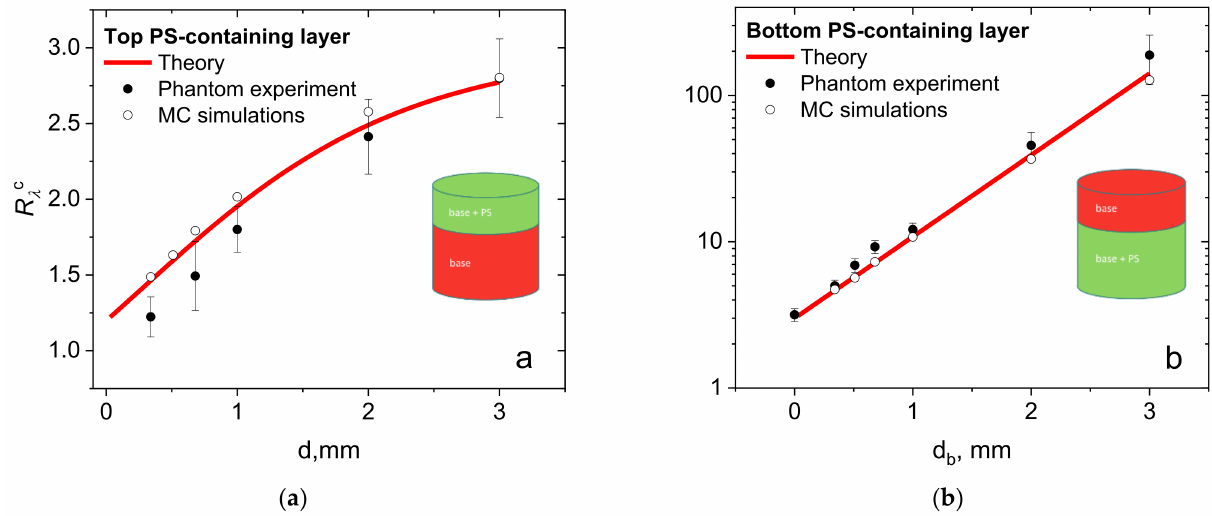
Figure 5. Experimentally measured fluorescence signal ratio for the agarose biotissue phantoms with ( a ) a PS-containing top layer and ( b ) a PS-containing bottom layer versus the PS localization depth, corresponding analytical dependencies and results of the Monte Carlo